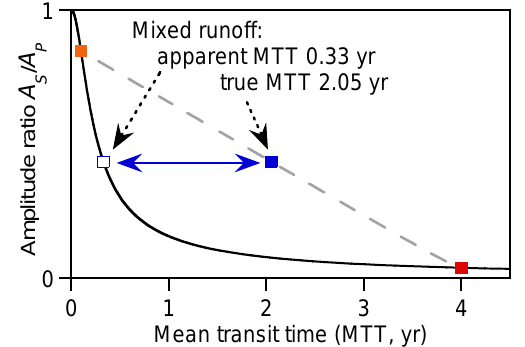
Figure 5. Illustration of the aggregation error that arises when mean transit time is inferred from seasonal tracer cycles in mixed runoff from two landscapes with contrasting transit-time distribu- tions (e.g., Fig. 4). The relationship between MTT and the ampli- tude ratio ( A S /A P ) of annual cycles in streamflow and precipita- tion is strongly nonlinear (black curve). Seasonal cycles from sub- catchments with MTT of 0.1 years ( A S /A P = 0.85, orange square) and 4 years ( A S /A P = 0.04, red square) will mix along the dashed gray line. A 50:50 mixture of the two sources will have a MTT of (4 + 0.1)/2 = 2.05 years and an amplitude ratio A S /A P of 0.43 (blue square). But if this amplitude ratio is interpreted as coming from a single catchment (Eq. 10), it implies a MTT of only 0.33 years (open square), 6 times shorter than the true MTT of the mixed runoff. Figure 6. Exponential transit-time distributions for subcatch-